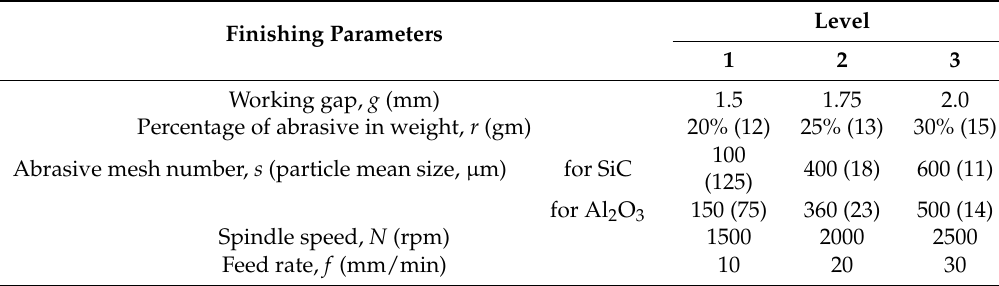
Table 1. The factors and levels of finishing